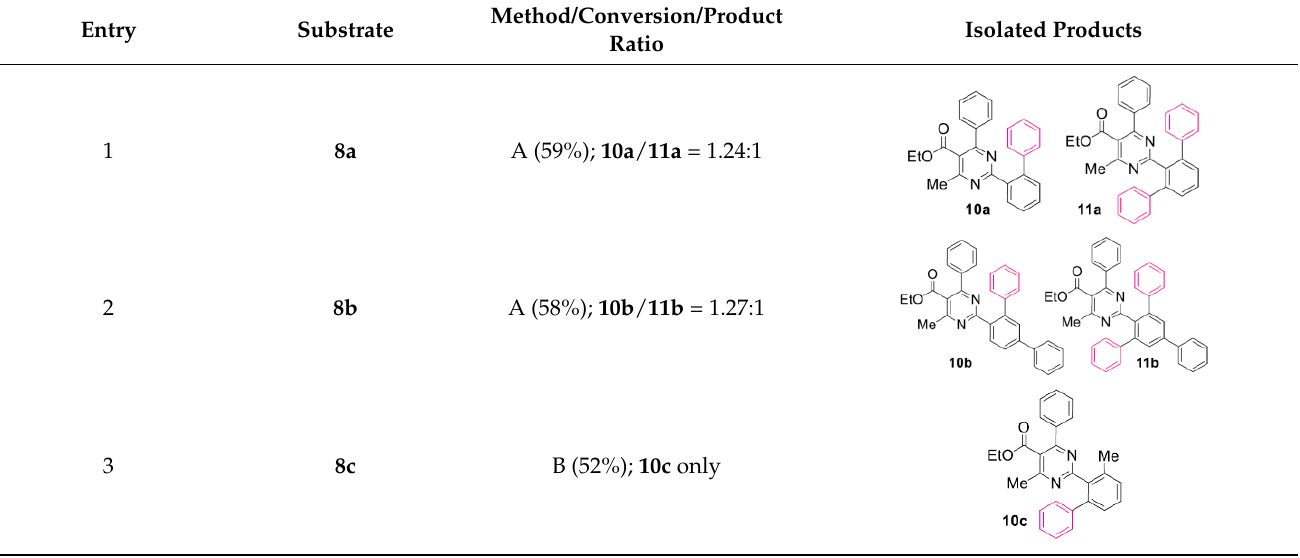
Table 3. Isolated products from LED-activated, Pd-catalyzed C–H arylation reaction.